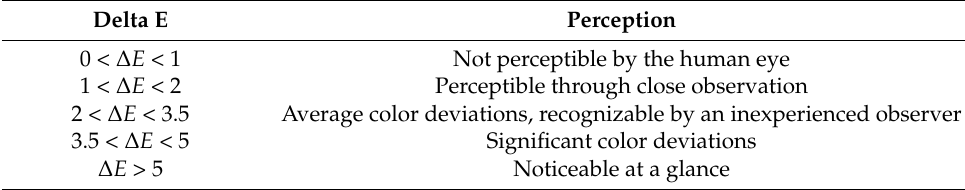
Table 6. Scale of the ∆ E value. Delta E